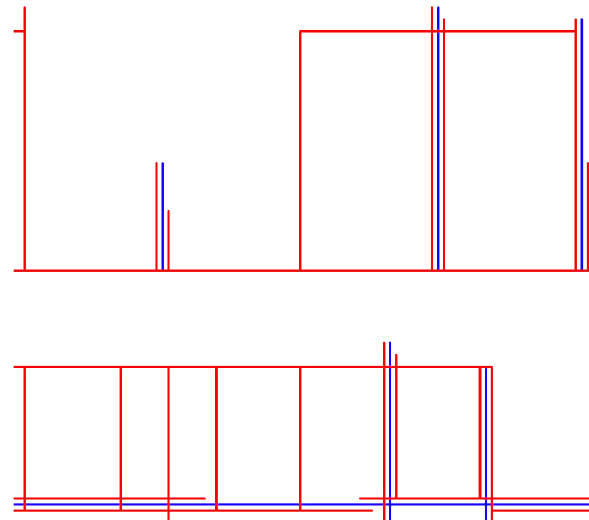
Figure 8 . The cell centres are converted into lines in two directions